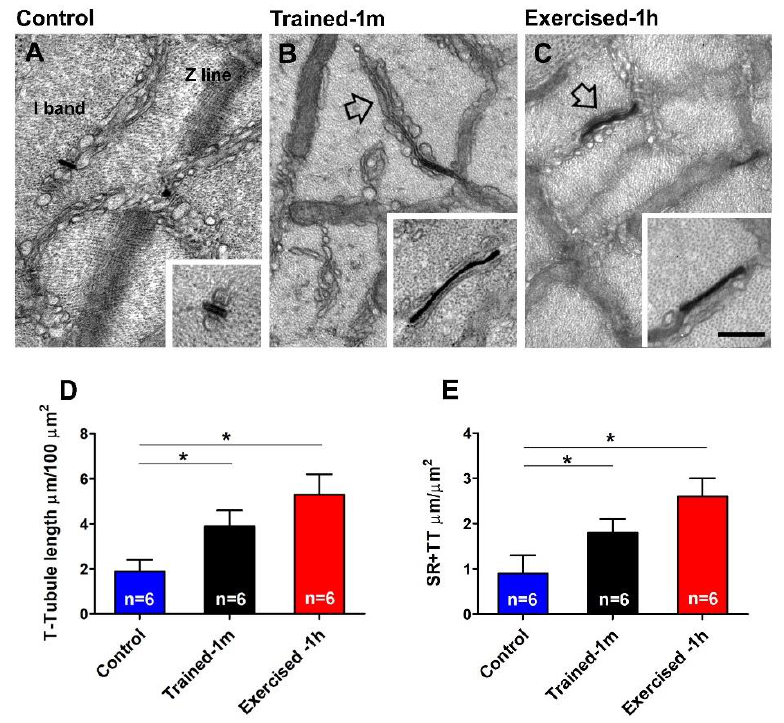
Figure 4. Electron-micrographs and quantitative analysis of the TT network extension at the I band: ( A – C ) Representative EM images showing TTs (stained with ferrocyanide-precipitate) at the I band (see insets in( B ) and ( C ); inset in ( A ) shows a T-tubule stained at the triad junction . ( D , E ) Extension of TTs at the I band in 100 µm 2 of section and extension of SR-TT contacts at the I band . Data are shown as mean ± SEM (* p < 0.05; the two ends of the line with asterisk indicate which two groups are being compared). Note, n = number of EDL analyzed. Scale bar: ( A – C ) = 0.1 µm; insets = 0.2 µm. See also Supplementary Figure S3 for quantitative analysis of TT extension after the ES protocol.